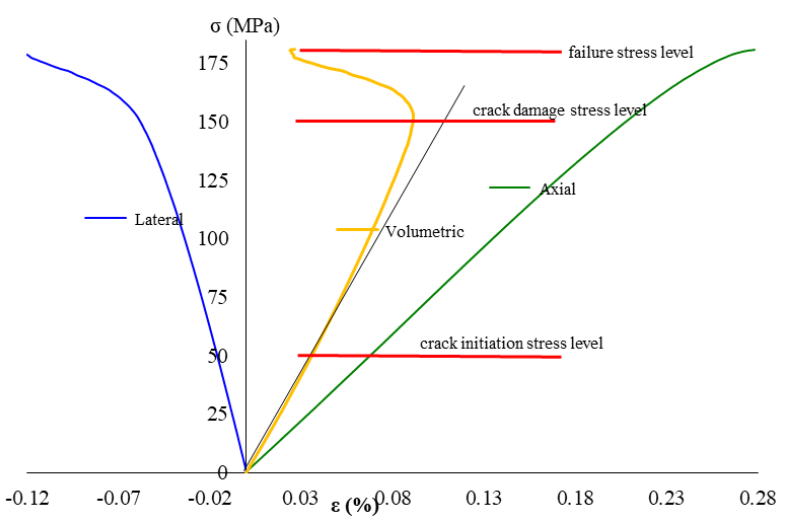
Fig. 5. Axial stress – volumetric strain curve with the threshold of crack initiation and crack damage and failure stress for Hungarian granitic sample (uniaxial compression case).